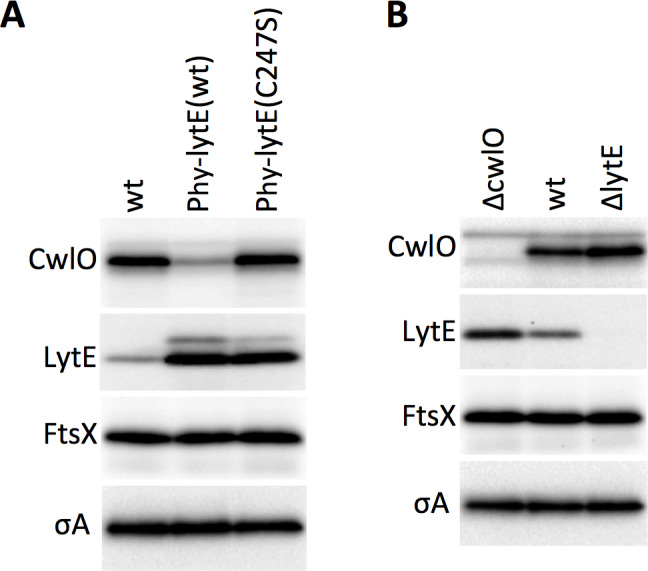
CwlO levels are modulated in response to changes in D,L-endopeptidase activity.(A) Immunoblot analysis of CwlO, LytE, and FtsX protein levels in wild-type (wt) and strains harboring a strong IPTG-inducible promoter fusion to lytE (Phy-lytE) or the LytE catalytic mutant C247S. Cells with high levels of LytE (but not the catalytic mutant) have low levels of CwlO. FtsX levels remain unchanged under all conditions. (B) Immunoblot analysis of CwlO, LytE, and FtsX protein levels in wild-type (wt) and in strains lacking CwlO (∆cwlO) or LytE (∆lytE). Cells lacking LytE have a modest increase in CwlO levels. Cells lacking CwlO have ~2 fold higher levels of LytE. FtsX levels remain unchanged under all conditions. For both (A) and (B), strains were grown in LB medium and harvested at an OD600 ~0.4. Strains harboring Phy-lytE or Phy-lytE(C247S) were induced with 50 µM IPTG for 60 min. SigA levels were analyzed to control for loading. Immunoblots from one of two biological replicates are shown.